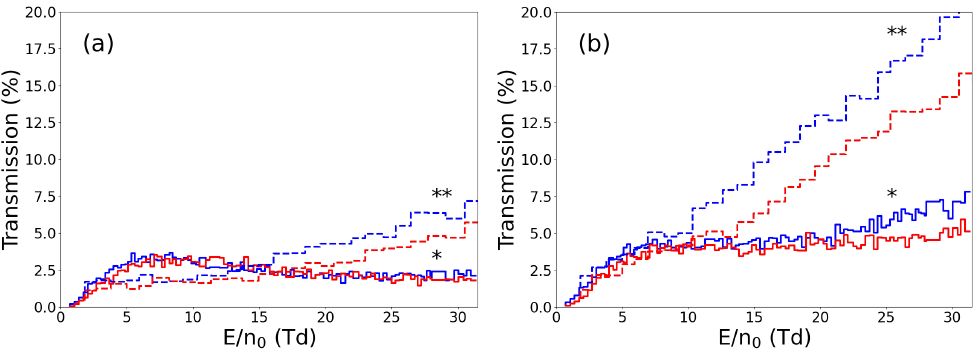
Figure 5. Ion transmission for unfocused (*) and focused (**) beams for both ground (blue) and metastable states (red) and for ( a ) 1mm and ( b ) 2mm exit diameter nozzles. Dash-line: focused beam; solid line: unfocused